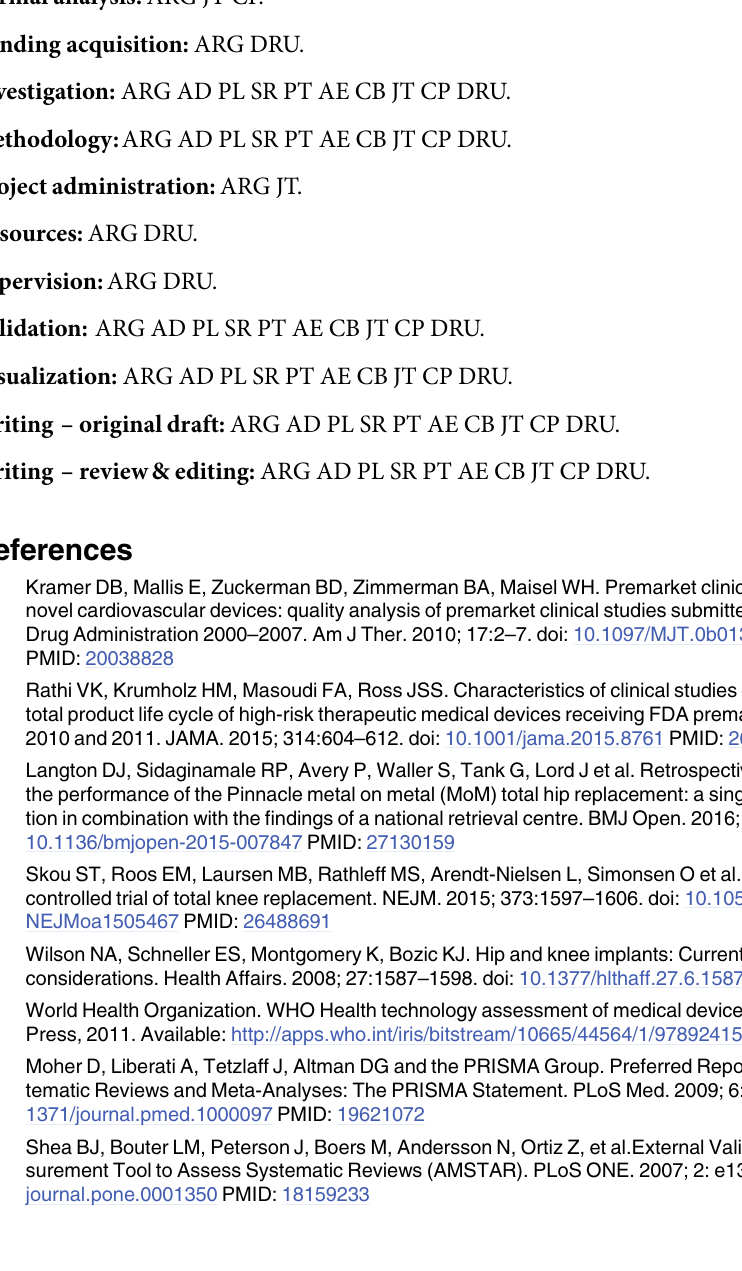
S4 Table. Data extracted from primarystudies and references.